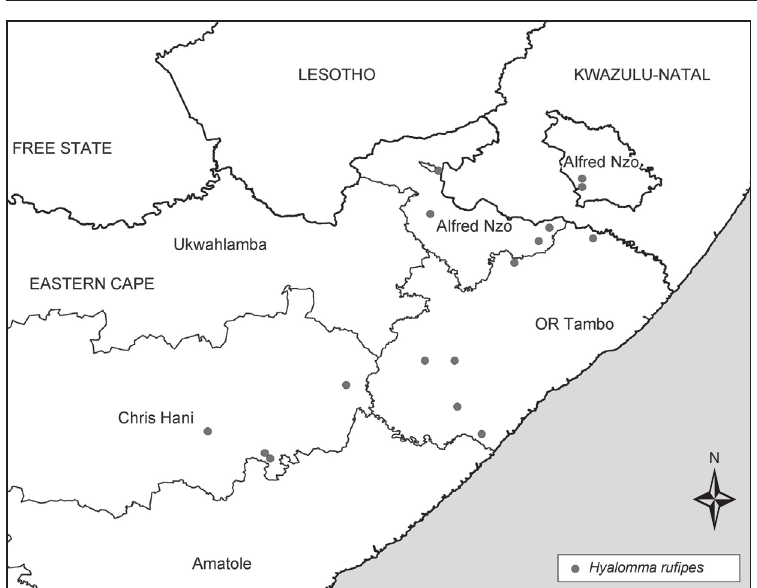
FIG. 2 The geographic distribution of Hy a lom ma rufipes in the eastern region of the Eastern Cape Province, South Africa